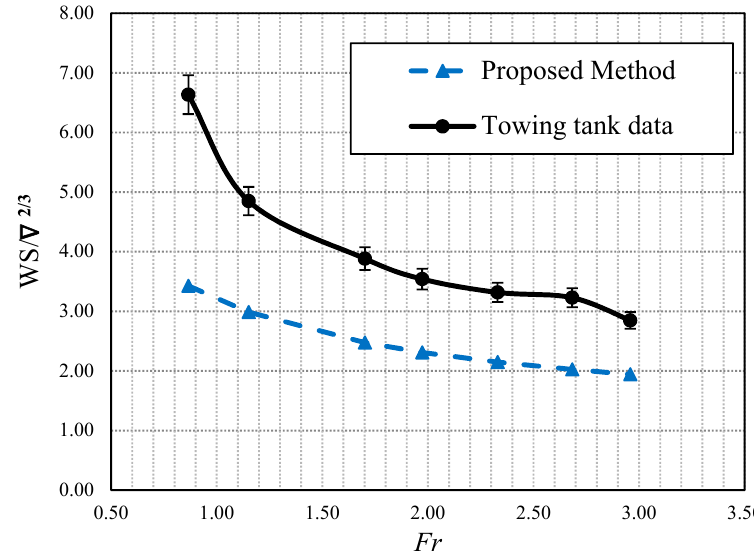
Figure 11. The dynamic wetted surface: 2D + T method vs. experimental results.